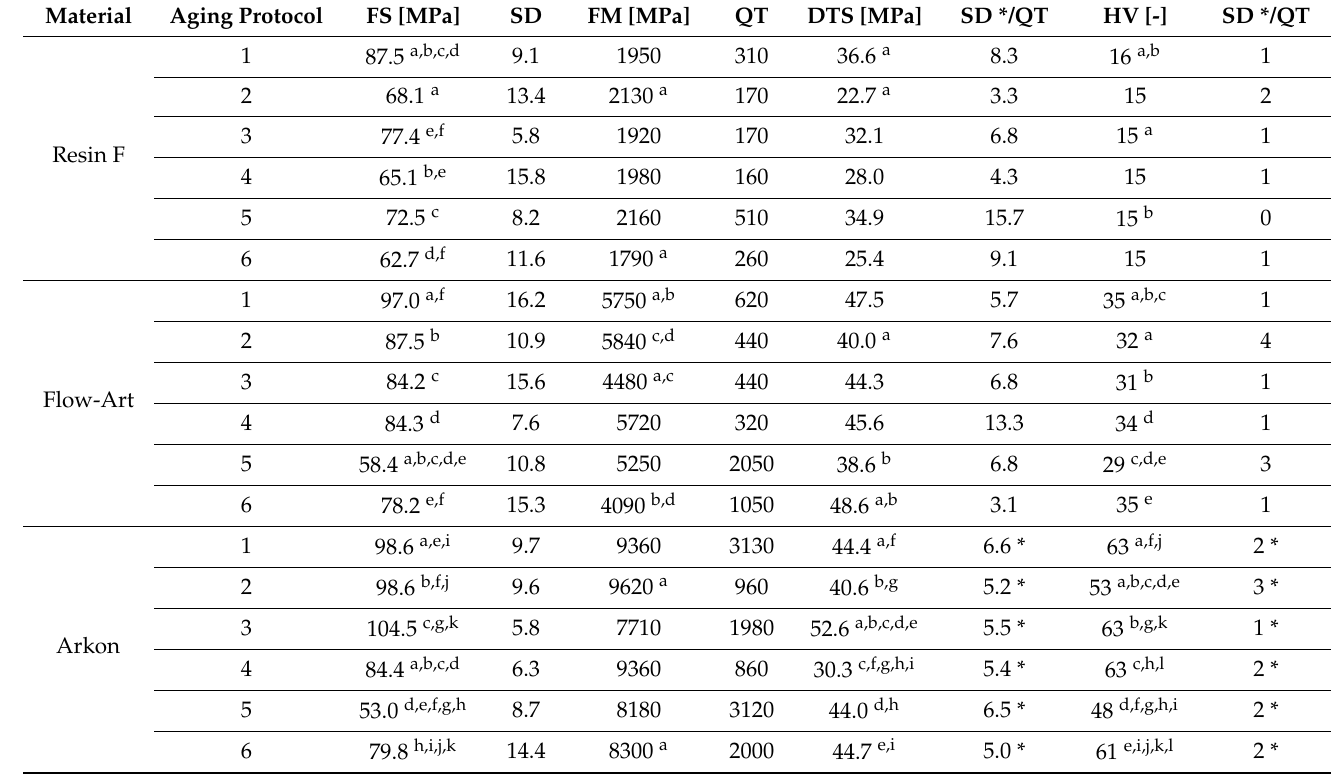
Table 1. The results of flexural strength (FS), diametral tensile strength (DTS) and hardness (HV) for tested materials after selected aging protocols. The results with the same assigned letter within the same material (Resin F, Flow-Art or Arkon) are significantly different ( p ≤ 0.05).